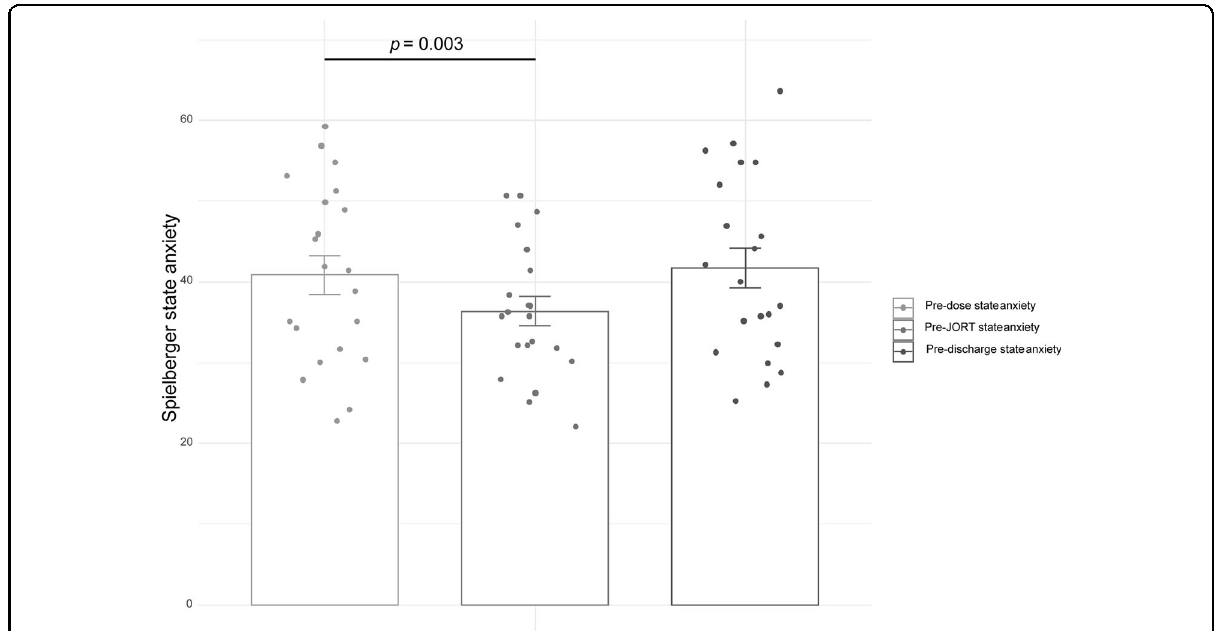
Fig. 3 Drug effects on Spielberger State Anxiety. State anxiety was signi fi cantly decreased by the low dose of BNC210 ( n = 21, error bars = 1 SEM).